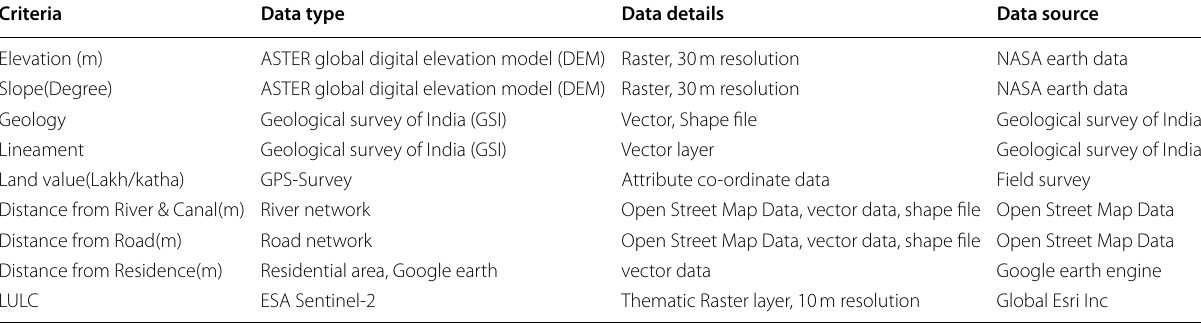
Table 1 Thematic layers used for landfill site selection, their sources and details